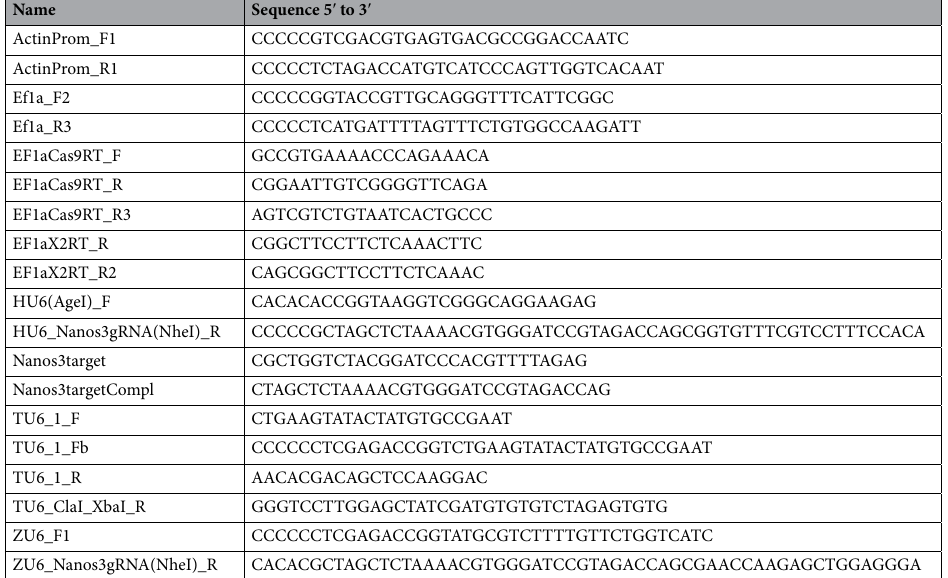
RNAs were in vitro transcribed using New England Biolabs HiScribe T7 High Yield RNA Synthesis kit (cat # E2040S) according to manufacturer’s protocol. PCR amplicons were produced using a forward primer with the T7 promoter sequence (TAA TAC GAC TCA CTA TAG G) as a 5 ′ extension followed by the target sequences listed in Supplementary Table S1 and a 3 ′ binding region to the gRNA scaffold (GTT TTA GAG CTA GAA ATA